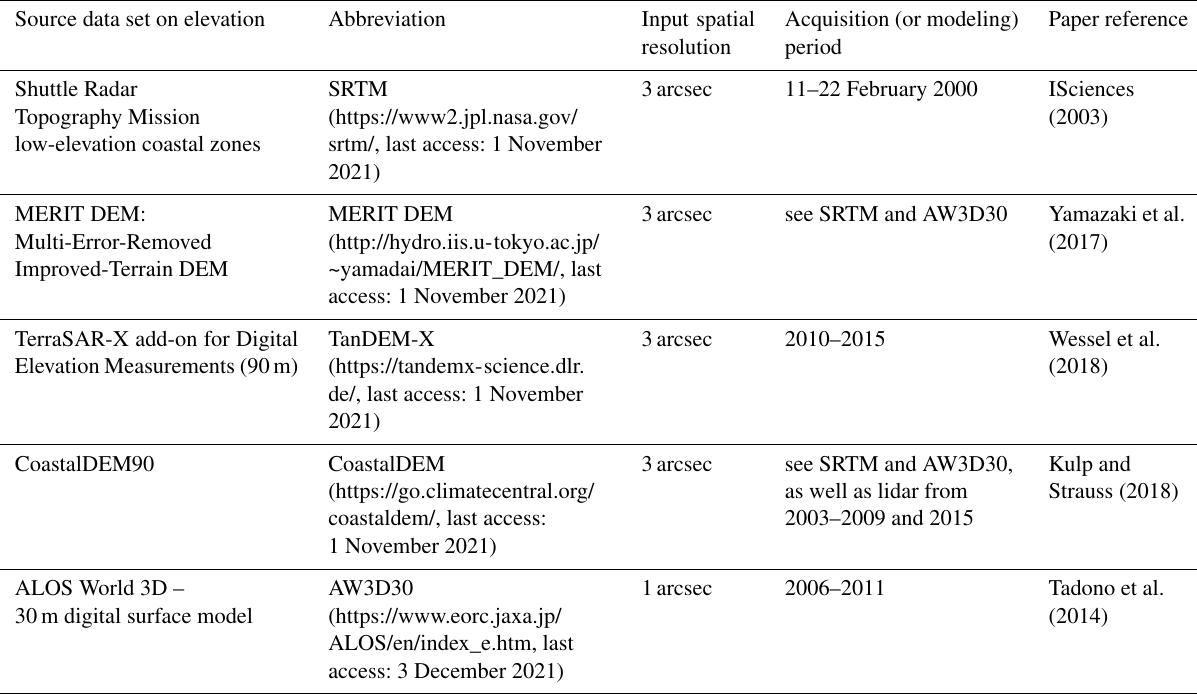
Table 1. Elevation data sets used in the construction of the low-elevation coastal zones (LECZs). Source data set on